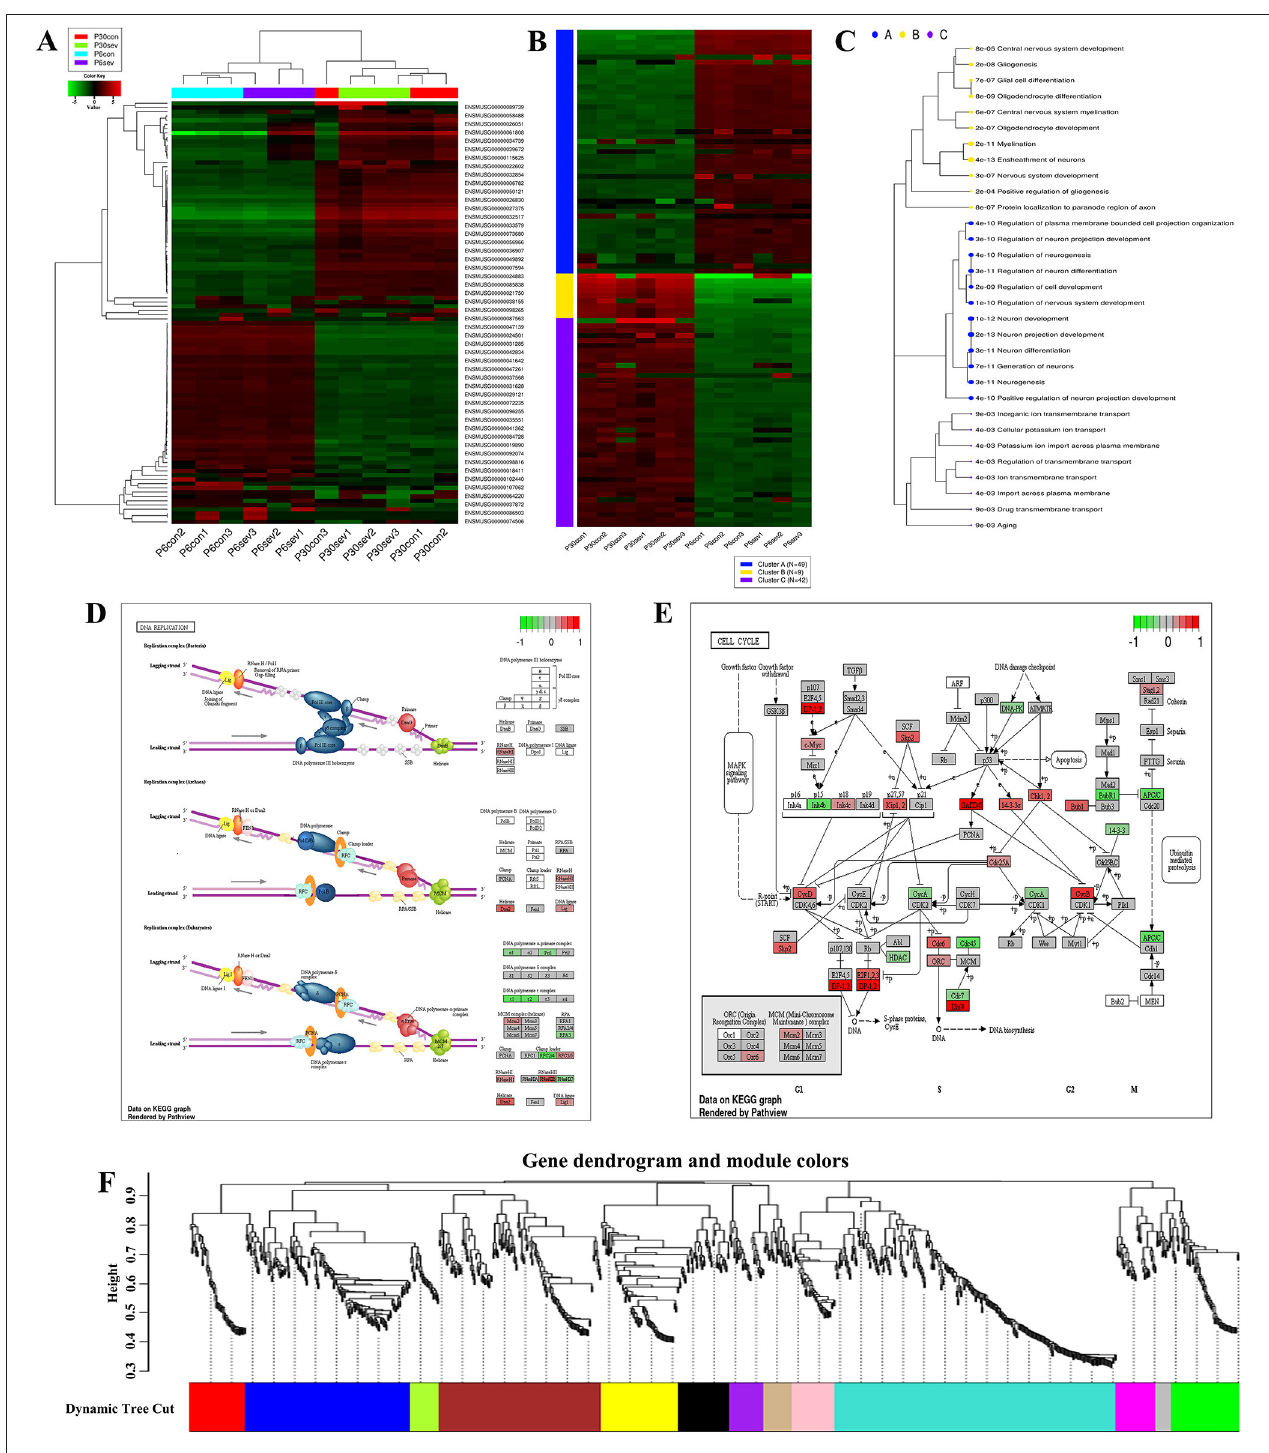
FIGURE 2 | Bioinformatic analysis for RNA-Seq data. (A) Hierarchical clustering of top 100 genes, and the color scale represents the relative genes expression in certain slide: green indicates low relative expression levels, red indicates high relative expression levels, and black indicates no change; (B) K-means clustering; (C) Enrichment analysis for GO terms, sizes of dot correspond to adjusted p -values; (D,E) parametric analysis of gene set enrichment (PGSEA) for the potential interaction networks and signaling pathways; (F) weighted gene correlation network analysis (WGCNA) for investigating the underlying correlations among genes and groups using network